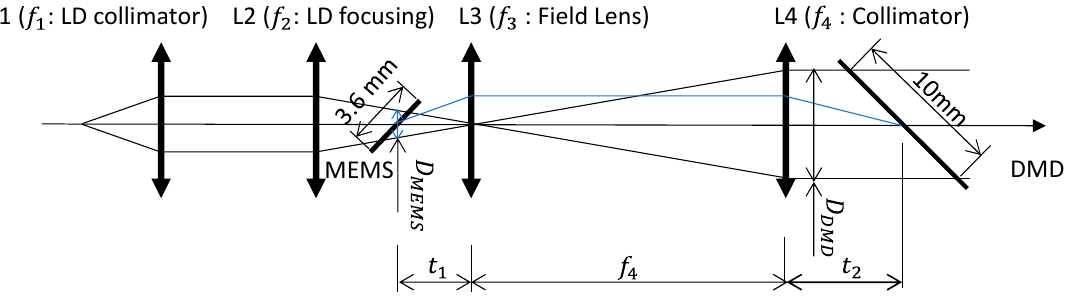
Figure 2. A first-order diagram of the lidar transmitter to expand the beam while matching the pupils of the 2D-MEMS mirror and DMD.